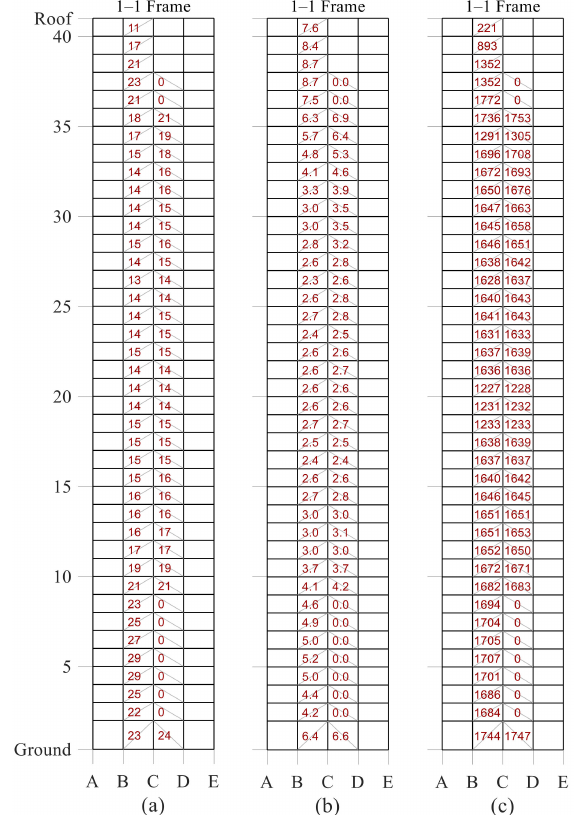
Figure 16. ( a ) Median peak damper displacements [mm], ( b ) median response of peak damper post-relief velocity ratio, and ( c ) median response of peak damper forces [KN]